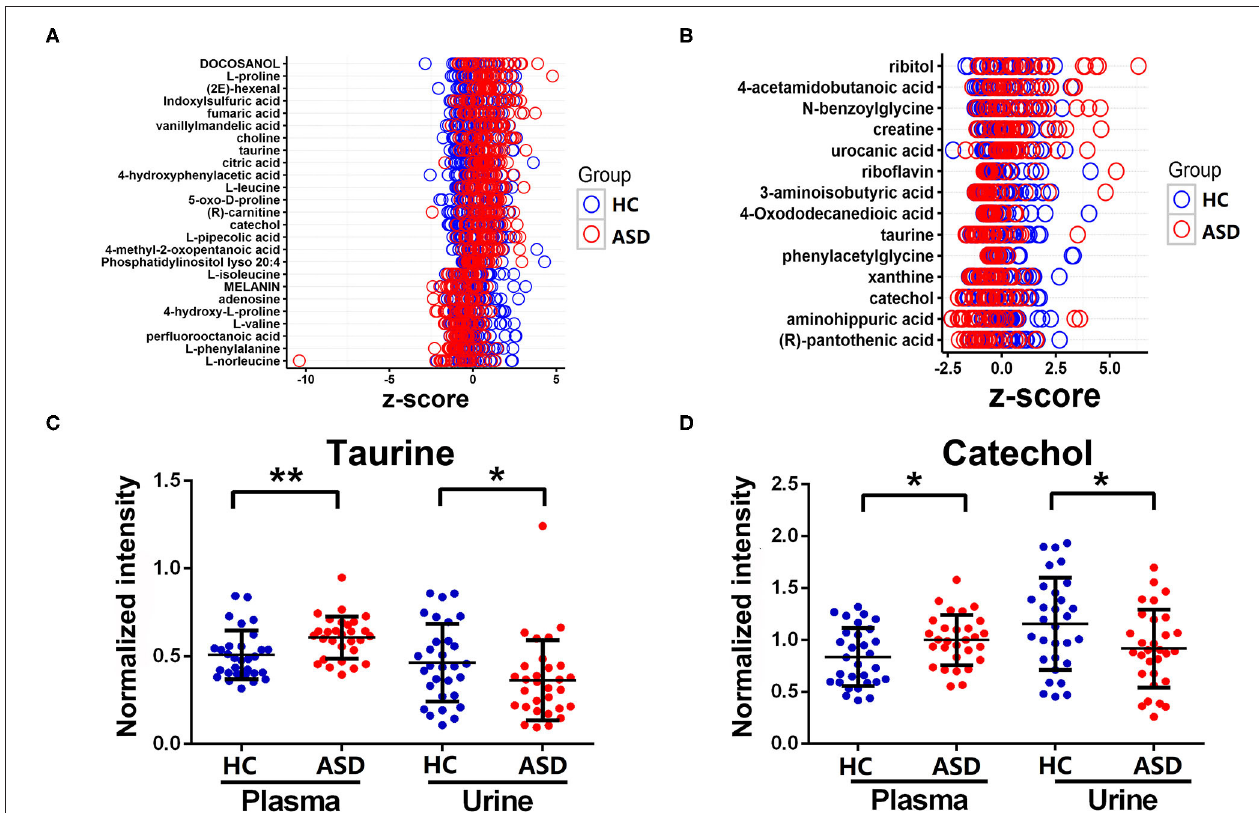
FIGURE 3 | The discriminating metabolites differ between ASD and HC groups. (A,B) Z -scores of the discriminating metabolites were plotted in plasma and urine samples. (C,D) Levels of taurine and catechol in plasma and urine samples. Data are presented as mean ± SD, * p < 0.05, ** p < 0.01.